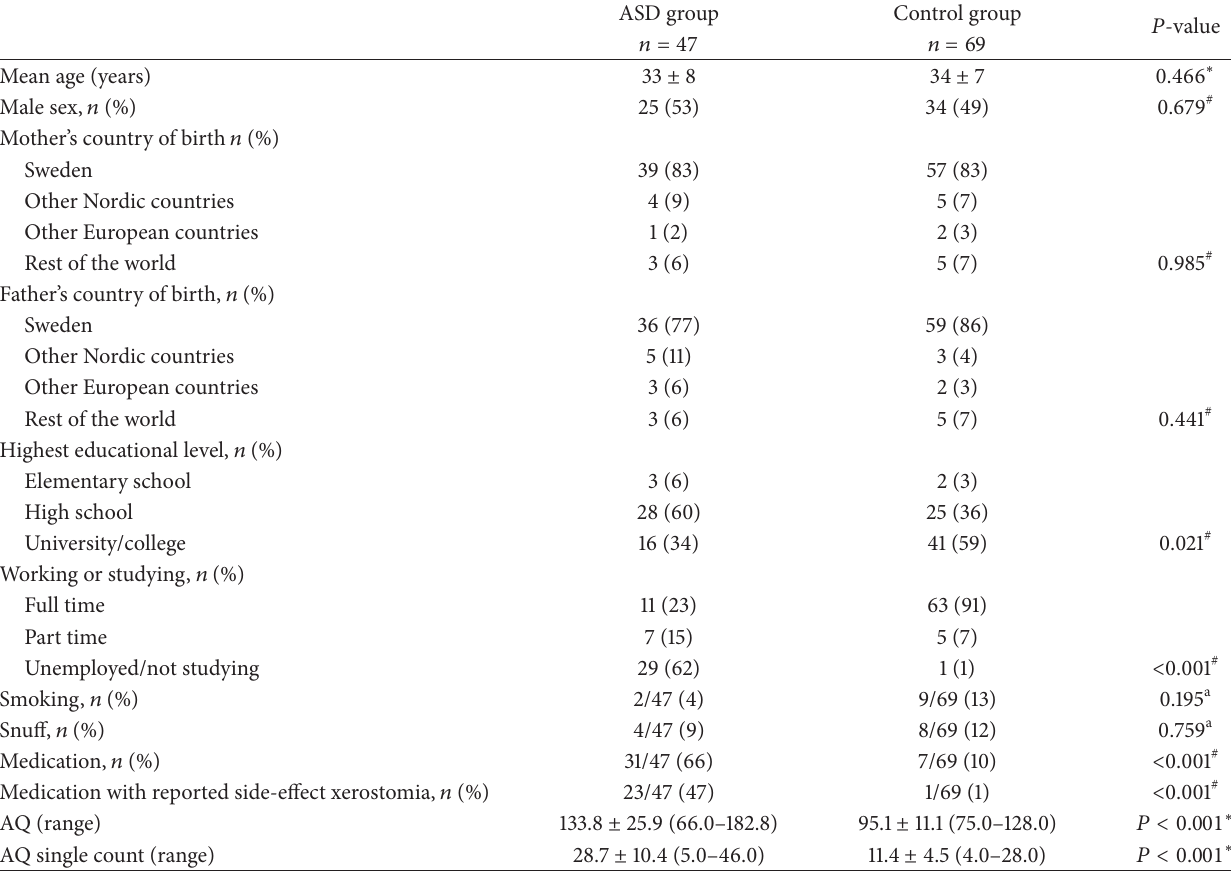
Table 1: Sociodemographic characteristics of adults with autism spectrum disorder (ASD) and